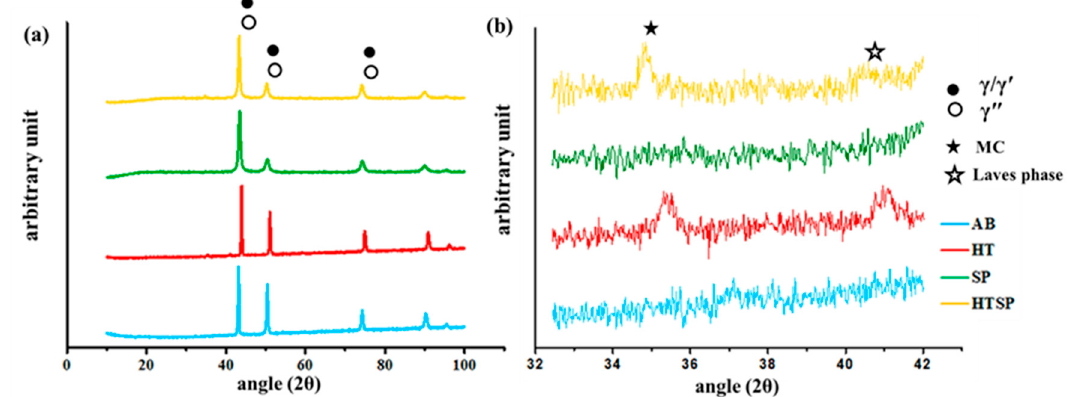
Figure 6. ( a ) XRD peaks of different phases in AB, HT, SP, and HTSP samples, and ( b ) Peaks of metal carbides (MC) and Laves phases with lesser intensities.